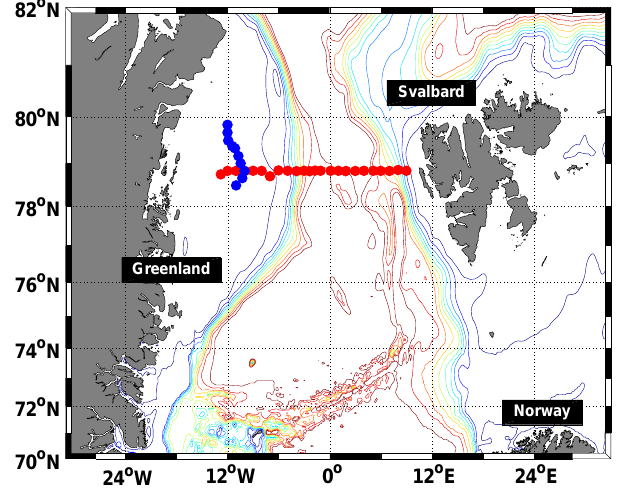
Figure 1. Sample stations of the ARK-XXVII/1 cruise in 2012. The zonal stations are highlighted as red dots and the meridional stations along the fast ice edge as blue dots. The depth contours are 250 : 250 :